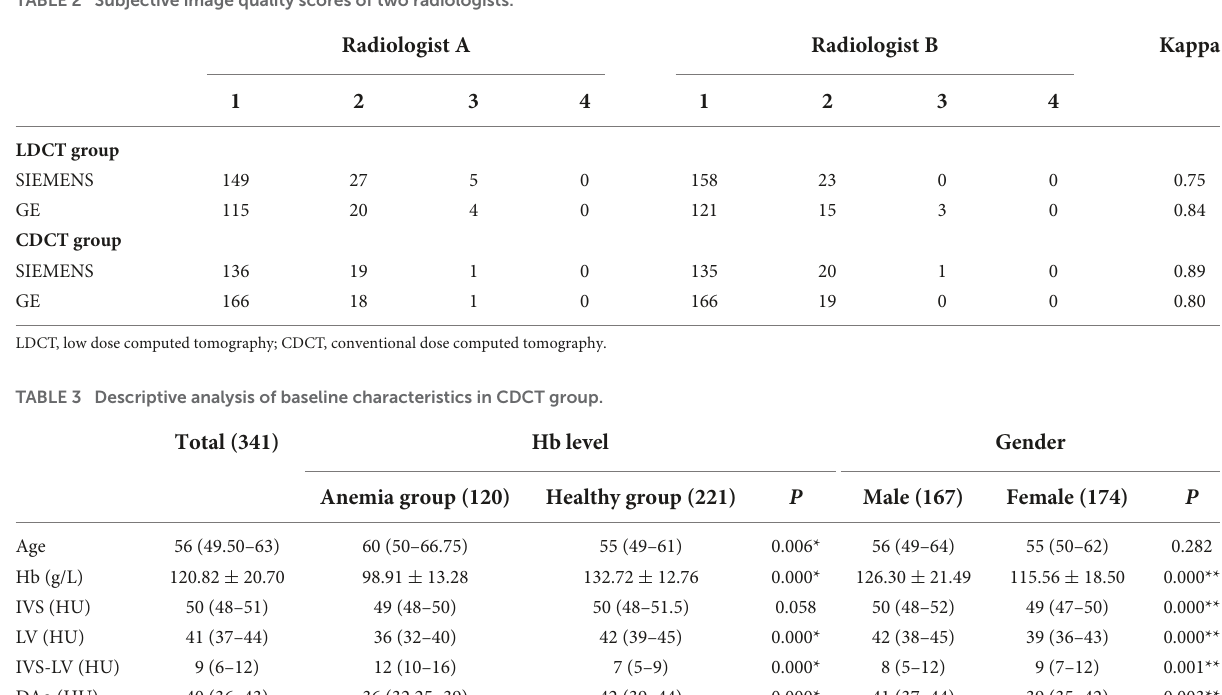
TABLE 2 Subjective image quality scores of two radiologists.